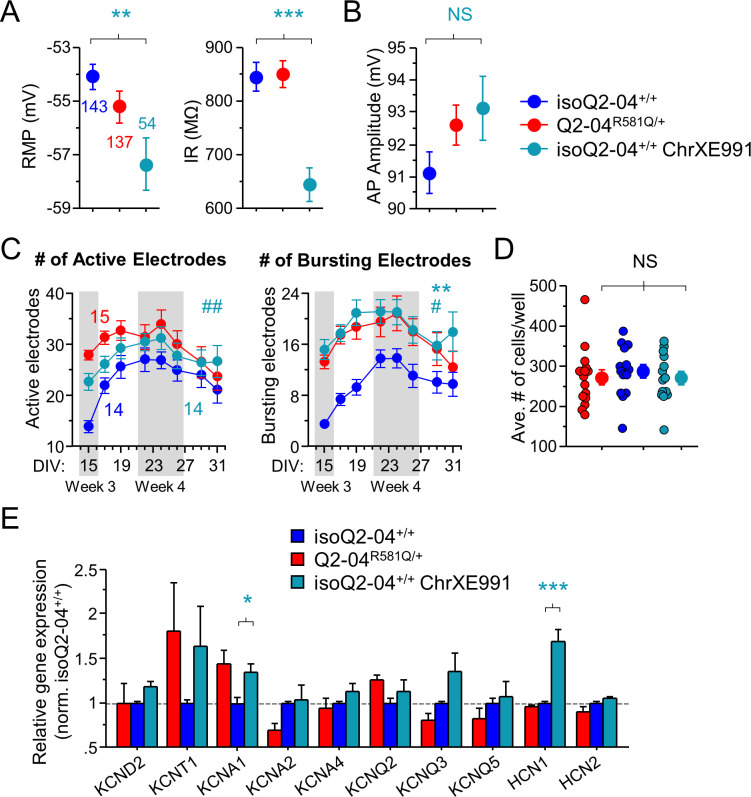
Intrinsic membrane properties and MEA recordings in chronically XE991-treated control neurons.(A) Passive membrane properties. RMP was more hyperpolarized and input resistance was significantly reduced with chronic XE991 treatment (isoQ2-04+/+ ChrXE991) in isogenic control neurons as compared to untreated isoQ2-04+/+ and Q2-04R581Q/+ neurons (ANOVA, Fisher’s PLSD posthoc test for RMP: **p=0.0014, *p=0.0383; Input resistance: ***p<0.0001, ***p<0.0001, respectively). Number of neurons analyzed is displayed within the figure and in Tables 1 and 2. (B) Action potential amplitudes were not different between cell lines and after chronic treatment with XE991 (See Figure 6C). (C) Longitudinal analysis of MEA recordings from days 15 to 31 in culture recorded from Q2-04R581Q/+, untreated isoQ2-04+/+ and chronically XE991-treated isoQ2-04+/+ neurons. There was no difference in the number of active electrodes between the three groups of neurons (repeated measures ANOVA for genotype group: F(2,280) = 3.22, p=0.0504; genotype groups/day interaction: F(7,280) = 2.61, ##p=0.0015). The number of bursting electrodes was significantly greater in chronically XE991-treated isoQ2-04+/+ neurons as compared to untreated isoQ2-04+/+ neurons (repeated measures ANOVA: F(2,280) = 7.15, **p=0.0011; Fisher’s PLSD: **p=0.0005) but no different from Q2-04R581Q/+ neurons (repeated measures ANOVA, Fisher’s PLSD: p=0.4806). Fourteen to 15 wells, displayed within the figure, were analyzed per genotype treatment group from two independent differentiations. Teal * or # indicate difference between chronically XE991-treated isoQ2-04+/+ and untreated isoQ2-04+/+ neurons. (D) Each MEA plate well was imaged during week 4 in culture. GFP-fluorescing neurons on the electrode field area were counted for each well of every plate. The average number of cells per well counted was not different between Q2-04R581Q/+ neurons (271.8 ± 18.5 neurons/well), isoQ2-04+/+ neurons (287.3 ± 17.2 neurons/well) and chronically XE991-treated isoQ2-04+/+ neurons (271.3 ± 16.1 neurons/well) (p=0.7645). NS: not significant. (E) Comparison of qPCR gene expression pattern of K+ channels between Q2-04R581Q/+, untreated isoQ2-04+/+ and chronically XE991-treated isoQ2-04+/+ at week 5. The was no difference in expression of KCND2, KCNT1, KCNA2, KCNA4, KCNQ2, KCNQ3, KCNQ5 or HCN2 between the three groups of neurons. KCNA1 and HCN1 were upregulated in chronically XE991-treated isoQ2-04+/+ neurons compared to untreated isoQ2-04+/+ neurons (t test: *p=0.0443, ***p=0.0002, respectively). Values displayed are from two independent differentiations normalized within each differentiation to Q2-04+/+. Values displayed are mean ± SEM.